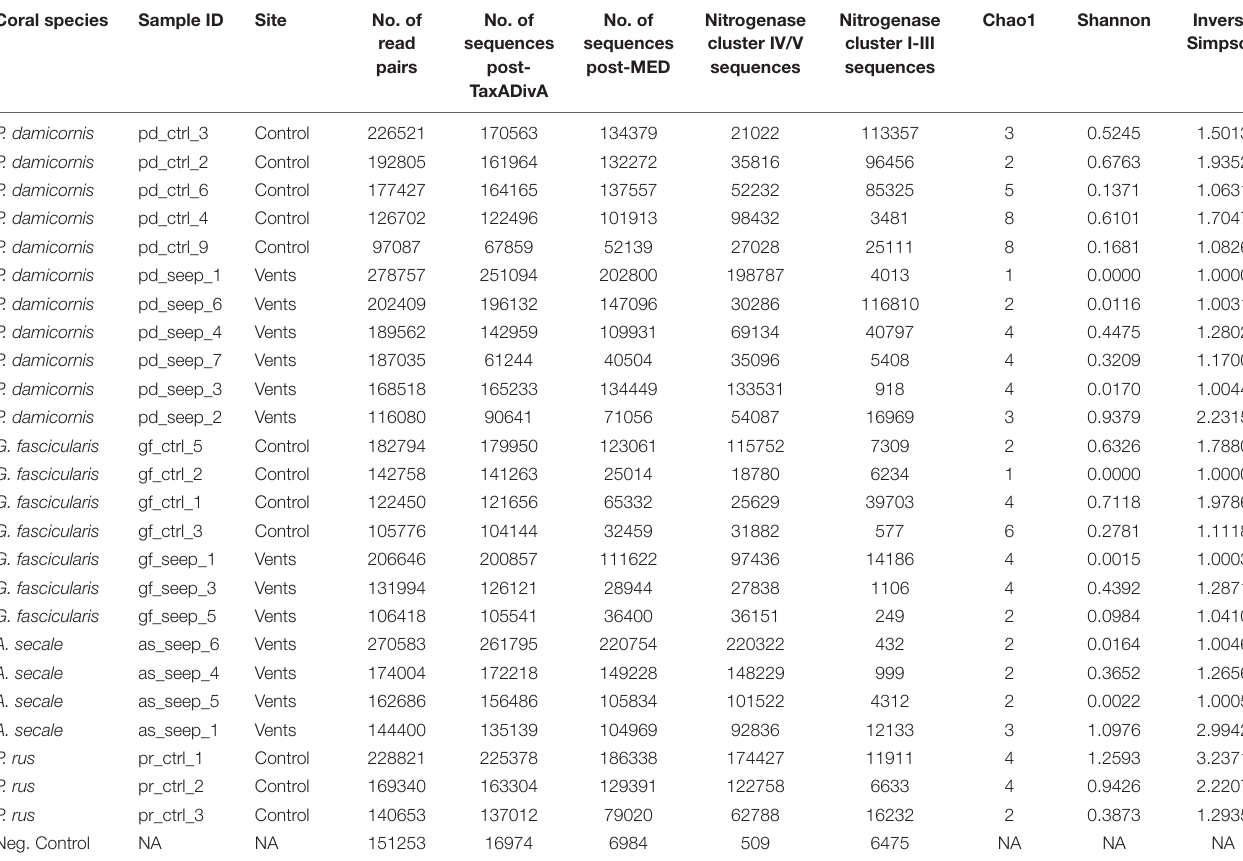
TABLE 1 | nifH sequencing overview and alpha diversity measures of 25 coral samples from a high pCO 2 (seep) and an ambient pCO 2 (control) site and 1 negative control, retained after sequence processing and nifH gene filtering. Coral